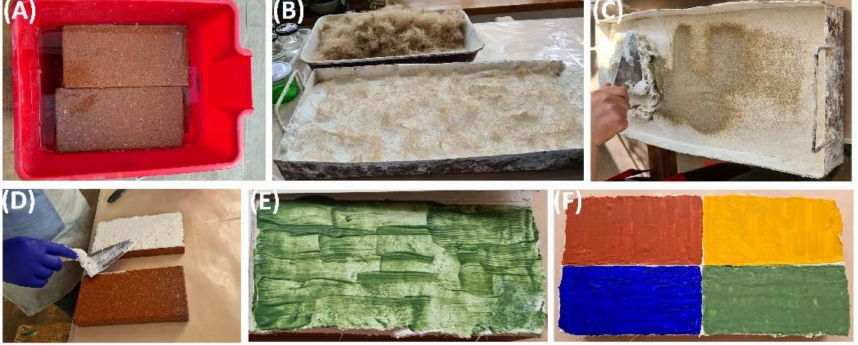
Figure 1. Preparation of the painted laboratory models. The stages of the procedure ( A – F ) were described in the main